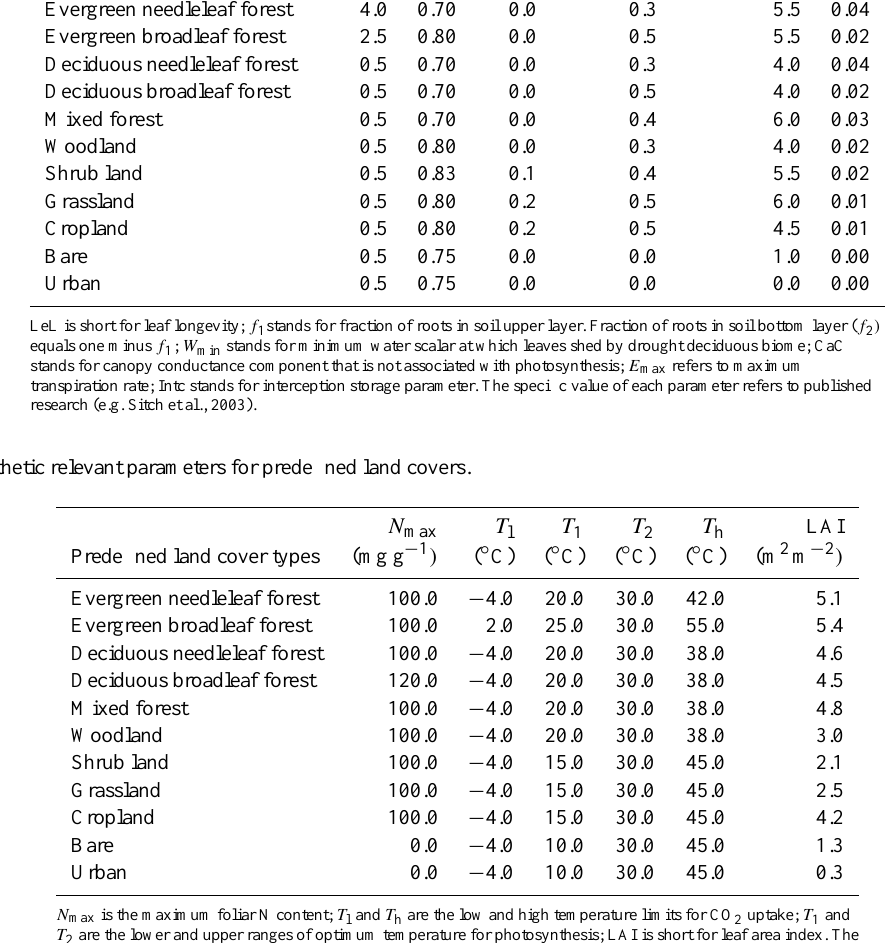
Table 1. Hydrologic relevant parameters for predefined land covers. LeL f 1 W min CaC Intc Predefined land cover types (years) (mm s − 1 ) (mm day − 1 ) Evergreen needleleaf forest Evergreen broadleaf forest